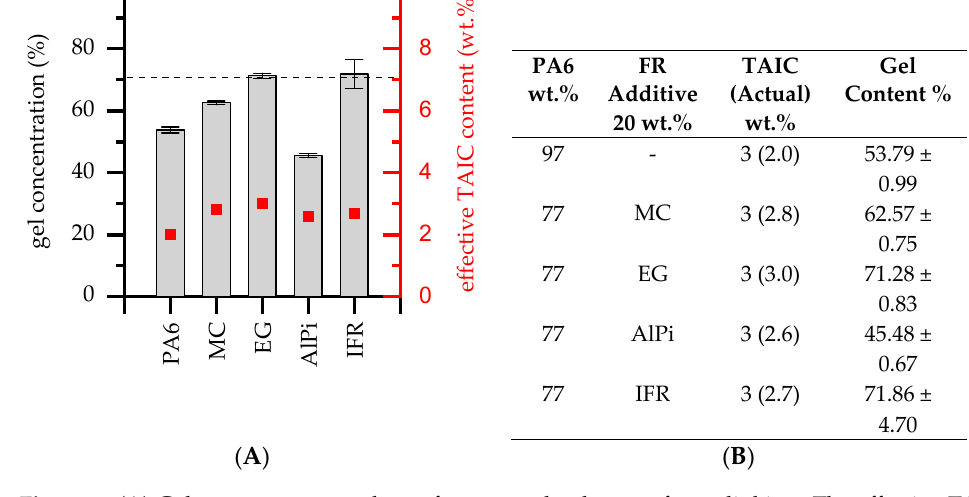
Figure 1. ( A ) Gel content measured as reference to the degree of crosslinking. The effective TAIC content was calculated from the PA6 fraction present within each formulation. ( B ) Summary of gel and actual TAIC